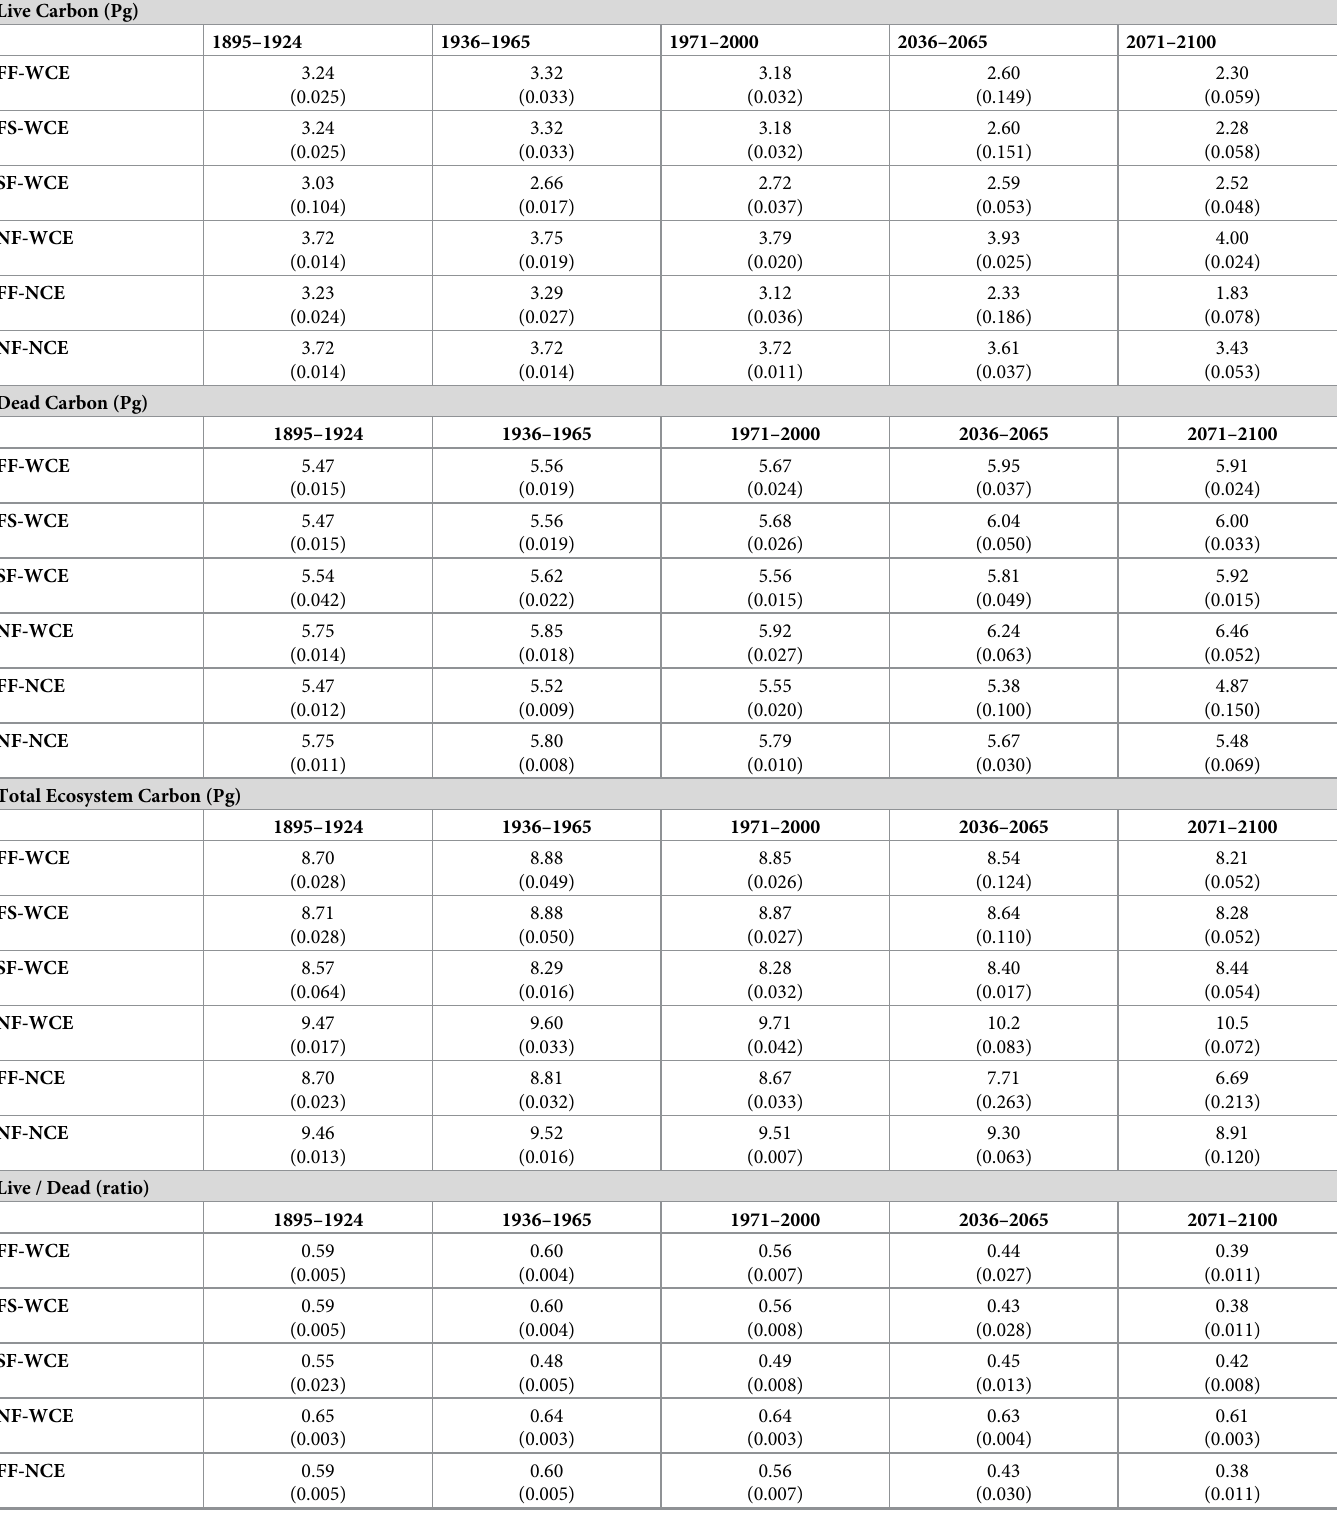
Table 7. Mean (standard deviation in parentheses) carbon pool values and live to dead C ratios by time